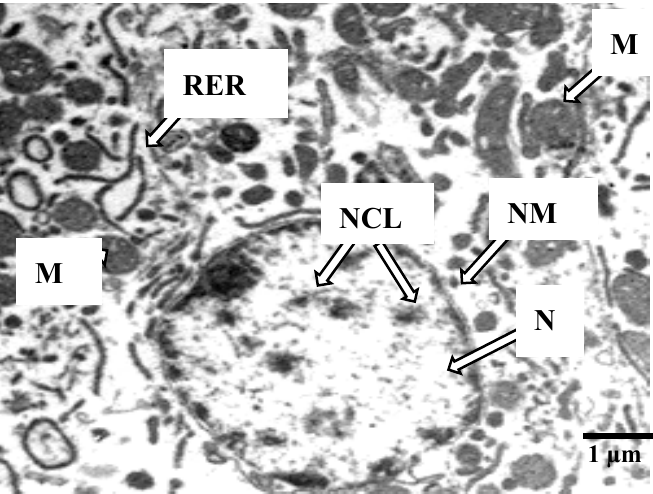
Figure 4. Electron micrograph of O. vittatus hepatocyte. Remarks: Nucleus (N), Nucleolus (NCL), Nuclear membrane (NM), Mitochondria (M), Rough endoplasmic reticulum (RER); Bar = 1 μ m.